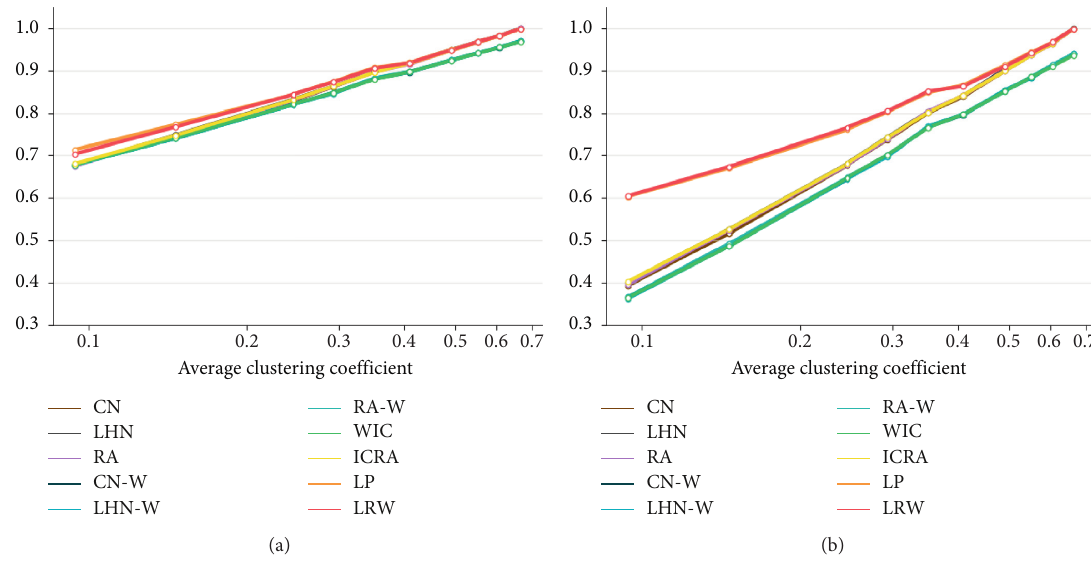
Figure 10: Performance of each predictor under AUC and W-index in WS-Group5. (a) Accuracy measured by AUC. (b) Accuracy measured by